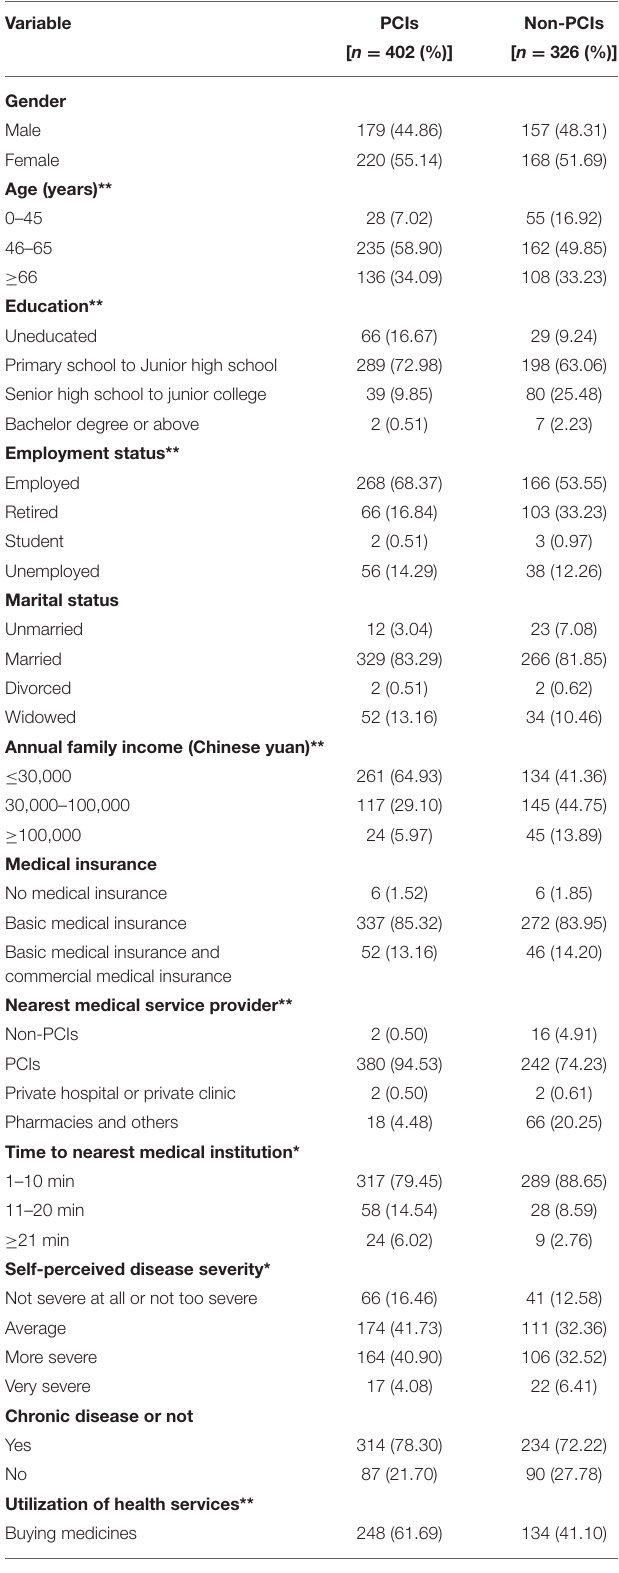
TABLE 2 | Demographic characteristics of participants by first-contact